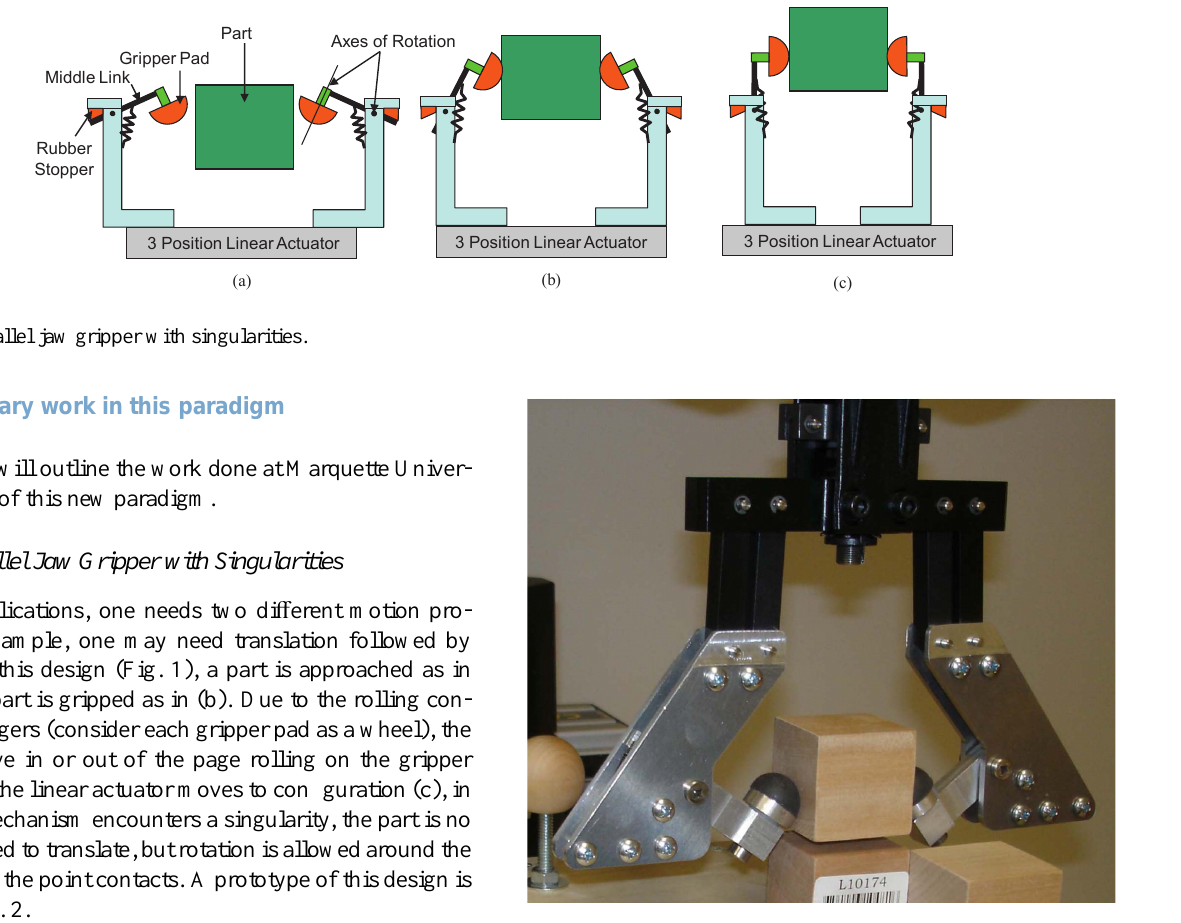
Figure 2. Prototype of parallel jaw gripper with